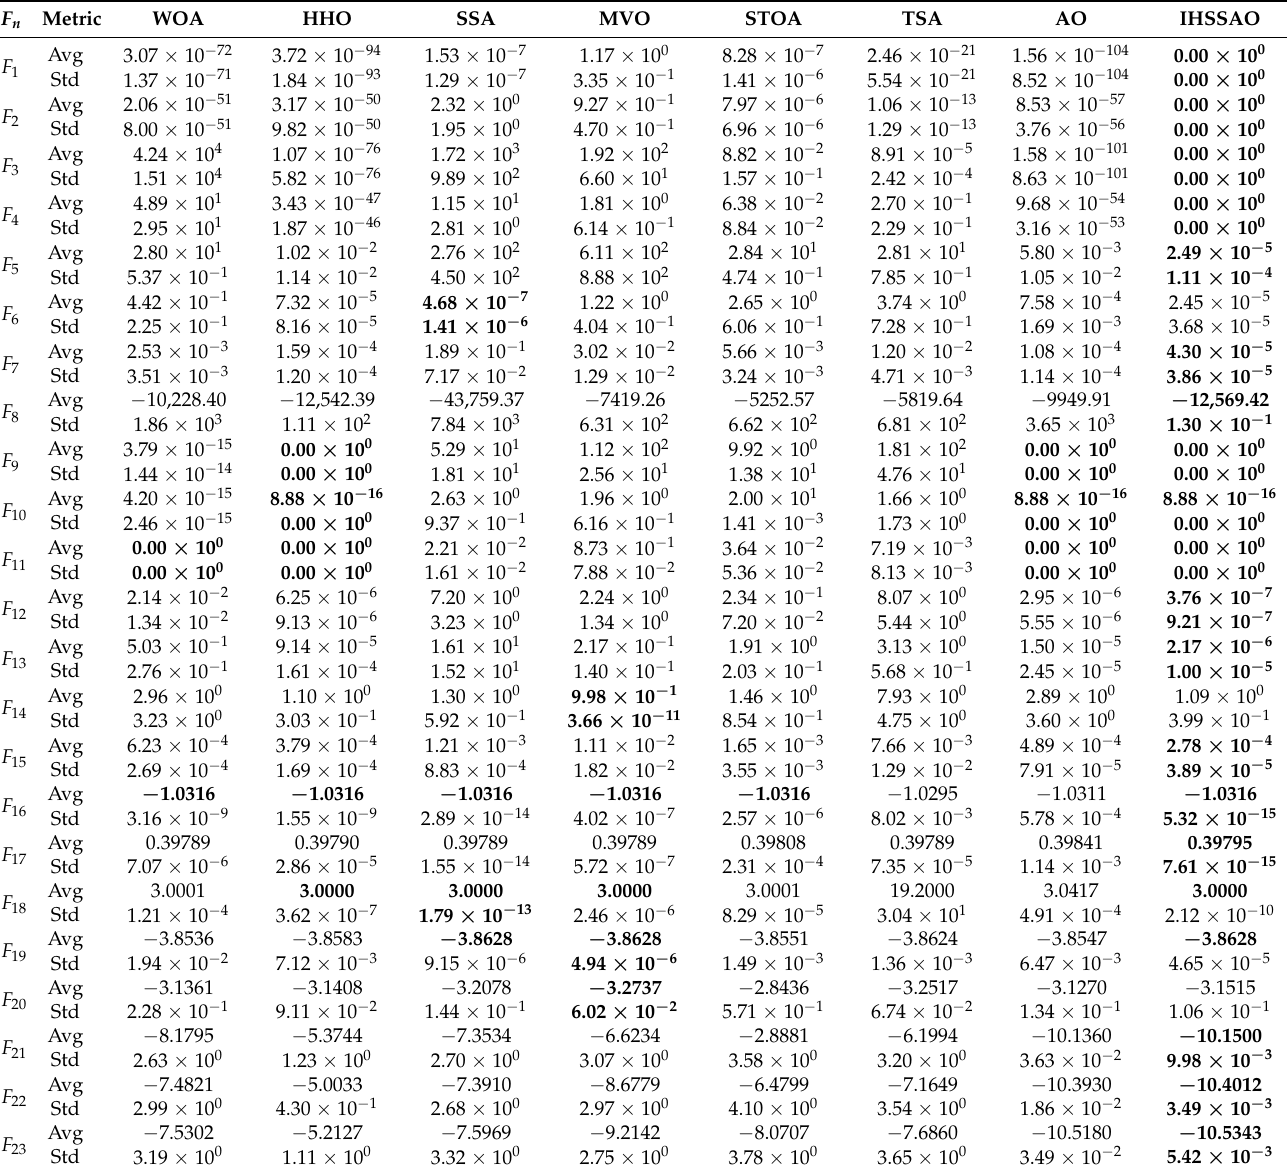
Table 5. Comparison results of various algorithms on 23 benchmark